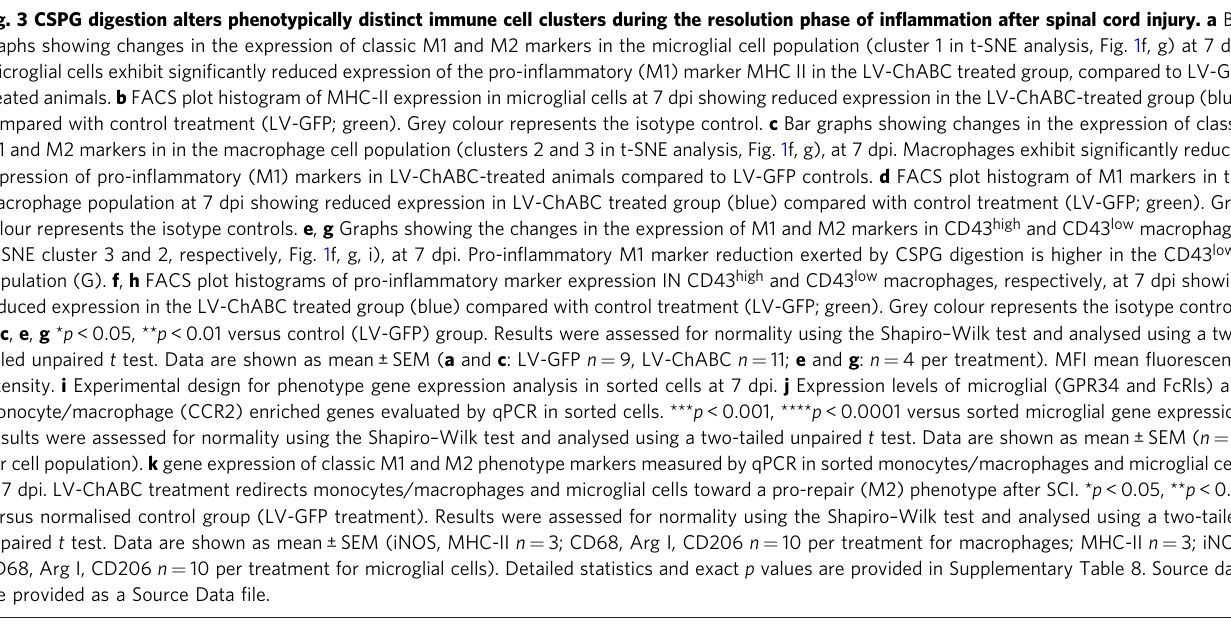
Fig. 3 CSPG digestion alters phenotypically distinct immune cell clusters during the resolution phase of in fl ammation after spinal cord injury. a Bar graphs showing changes in the expression of classic M1 and M2 markers in the microglial cell population (cluster 1 in t-SNE analysis, Fig. 1f, g) at 7 dpi. Microglial cells exhibit signi fi cantly reduced expression of the pro-in fl ammatory (M1) marker MHC II in the LV-ChABC treated group, compared to LV-GFP treated animals. b FACS plot histogram of MHC-II expression in microglial cells at 7 dpi showing reduced expression in the LV-ChABC-treated group (blue) compared with control treatment (LV-GFP; green). Grey colour represents the isotype control. c Bar graphs showing changes in the expression of classic M1 and M2 markers in in the macrophage cell population (clusters 2 and 3 in t-SNE analysis, Fig. 1f, g), at 7 dpi. Macrophages exhibit signi fi cantly reduced expression of pro-in fl ammatory (M1) markers in LV-ChABC-treated animals compared to LV-GFP controls. d FACS plot histogram of M1 markers in the macrophage population at 7 dpi showing reduced expression in LV-ChABC treated group (blue) compared with control treatment (LV-GFP; green). Grey colour represents the isotype controls. e , g Graphs showing the changes in the expression of M1 and M2 markers in CD43 high and CD43 low macrophages (t-SNE cluster 3 and 2, respectively, Fig. 1f, g, i), at 7 dpi. Pro-in fl ammatory M1 marker reduction exerted by CSPG digestion is higher in the CD43 low population (G). f , h FACS plot histograms of pro-in fl ammatory marker expression IN CD43 high and CD43 low macrophages, respectively, at 7 dpi showing reduced expression in the LV-ChABC treated group (blue) compared with control treatment (LV-GFP; green). Grey colour represents the isotype controls. a , c , e , g * p < 0.05, ** p < 0.01 versus control (LV-GFP) group. Results were assessed for normality using the Shapiro – Wilk test and analysed using a two- tailed unpaired t test. Data are shown as mean ± SEM ( a and c : LV-GFP n = 9, LV-ChABC n = 11; e and g : n = 4 per treatment). MFI mean fl uorescence intensity. i Experimental design for phenotype gene expression analysis in sorted cells at 7 dpi. j Expression levels of microglial (GPR34 and FcRls) and monocyte/macrophage (CCR2) enriched genes evaluated by qPCR in sorted cells. *** p < 0.001, **** p < 0.0001 versus sorted microglial gene expression. Results were assessed for normality using the Shapiro – Wilk test and analysed using a two-tailed unpaired t test. Data are shown as mean ± SEM ( n = 13 per cell population). k gene expression of classic M1 and M2 phenotype markers measured by qPCR in sorted monocytes/macrophages and microglial cells at 7 dpi. LV-ChABC treatment redirects monocytes/macrophages and microglial cells toward a pro-repair (M2) phenotype after SCI. * p < 0.05, ** p < 0.01 versus normalised control group (LV-GFP treatment). Results were assessed for normality using the Shapiro – Wilk test and analysed using a two-tailed unpaired t test. Data are shown as mean ± SEM (iNOS, MHC-II n = 3; CD68, Arg I, CD206 n = 10 per treatment for macrophages; MHC-II n = 3; iNOS, CD68, Arg I, CD206 n = 10 per treatment for microglial cells). Detailed statistics and exact p values are provided in Supplementary Table 8. Source data are provided as a Source Data fi